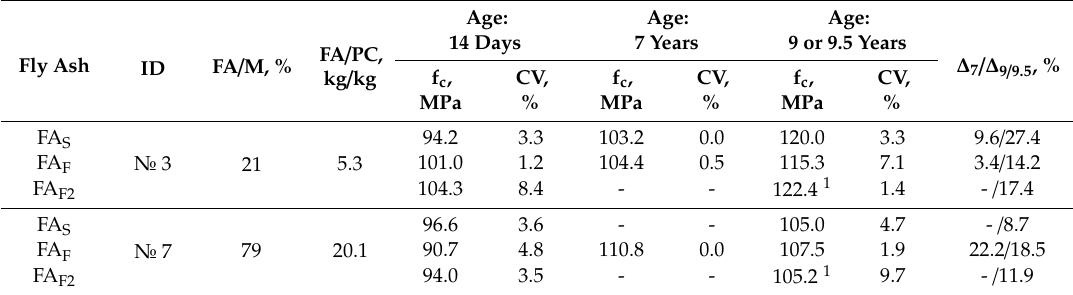
Table 2. Compressive strength of chosen vinyl-ester composites (ID: No. 3 and No. 7 acc. to Figure 5) with various types of fly ash (FA S , siliceous fly ash; FA F , fly ash from hard coal FBC; FA F2 , fly ash from